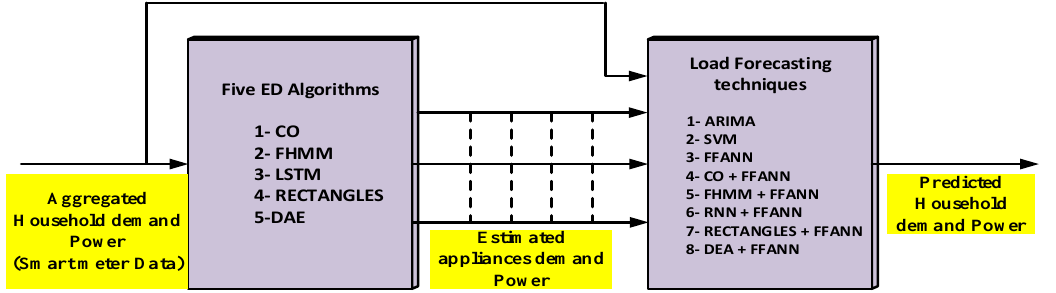
Figure 1. Block diagram for the proposed household load forecasting approach.